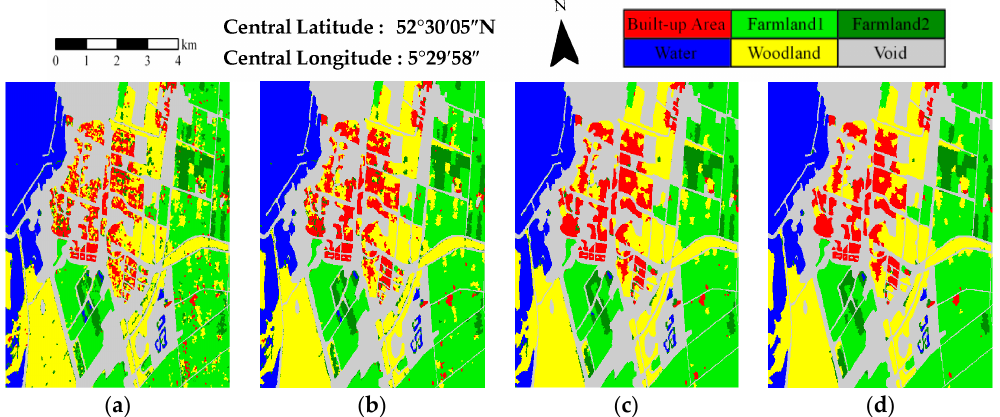
Figure 13. Classification results of the RADARSAT-2 image with different PLR step iteration times: